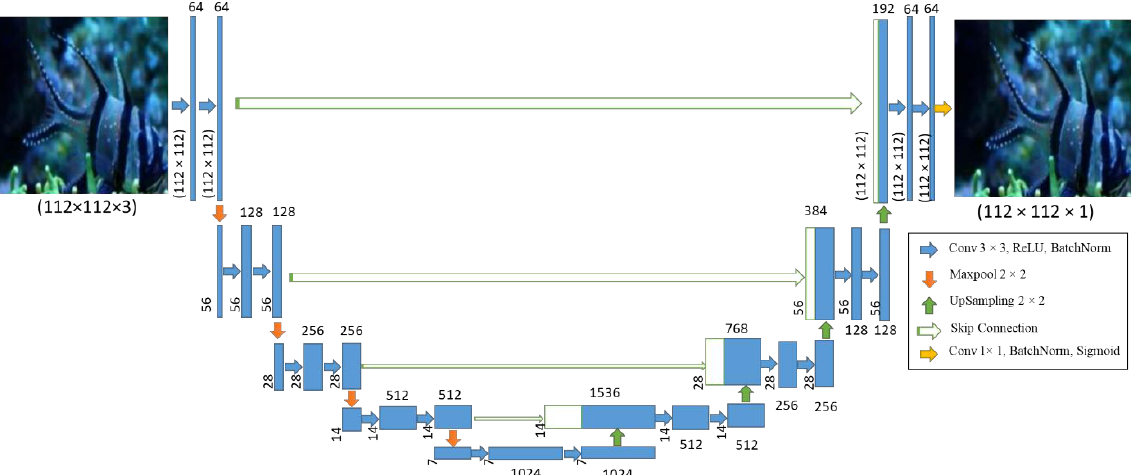
Fig. 2. Autoencoder for Enhanced image feature extraction .